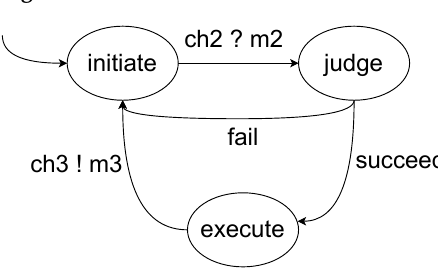
Figure 3. The client B model.